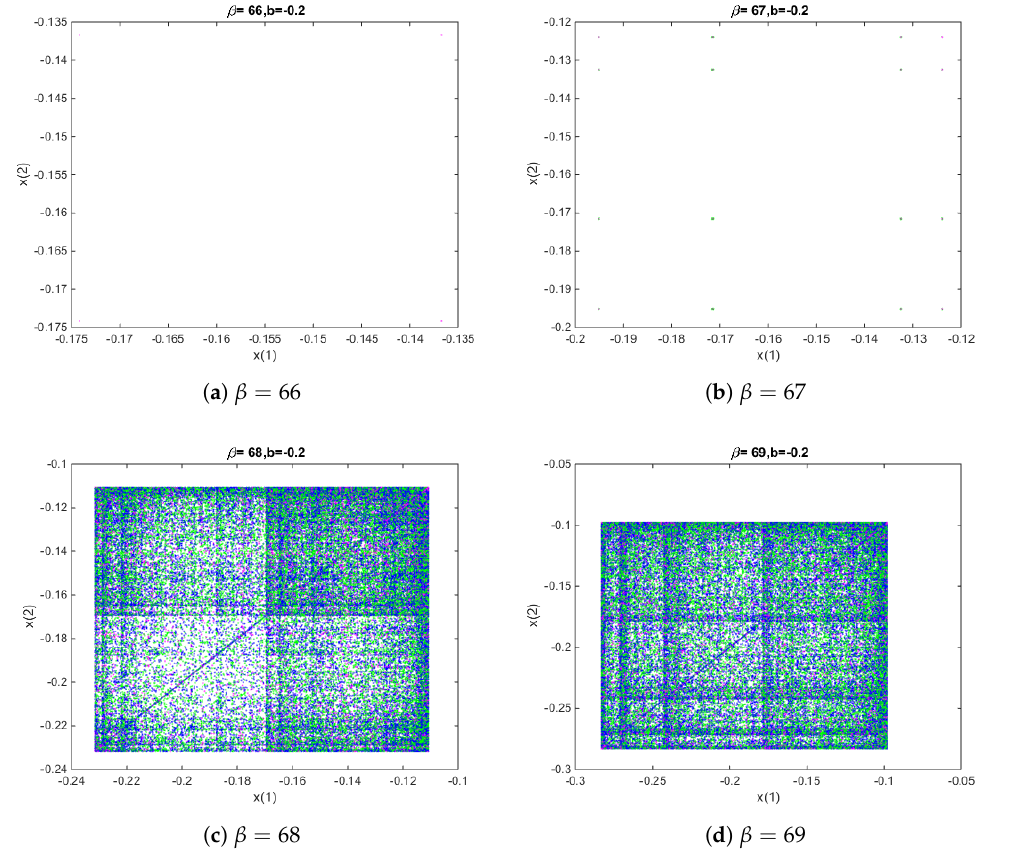
Figure 3. Strange attractors of M41 class for β values in the period-doubling cascade